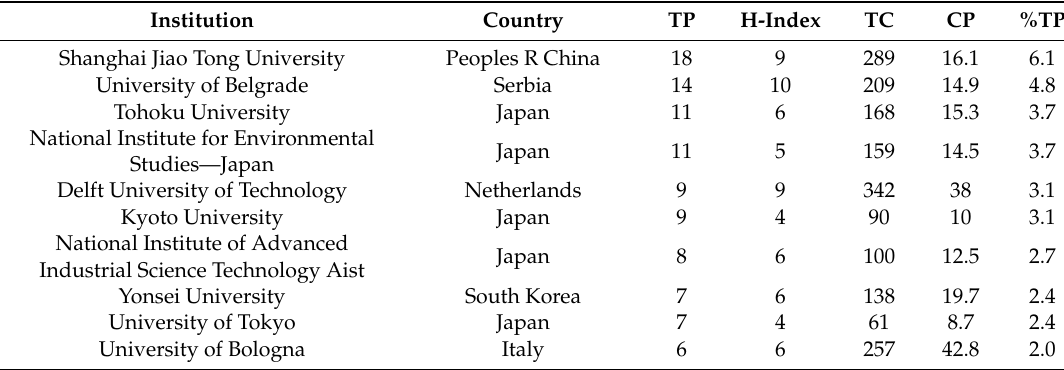
Table 3. The top 10 influential